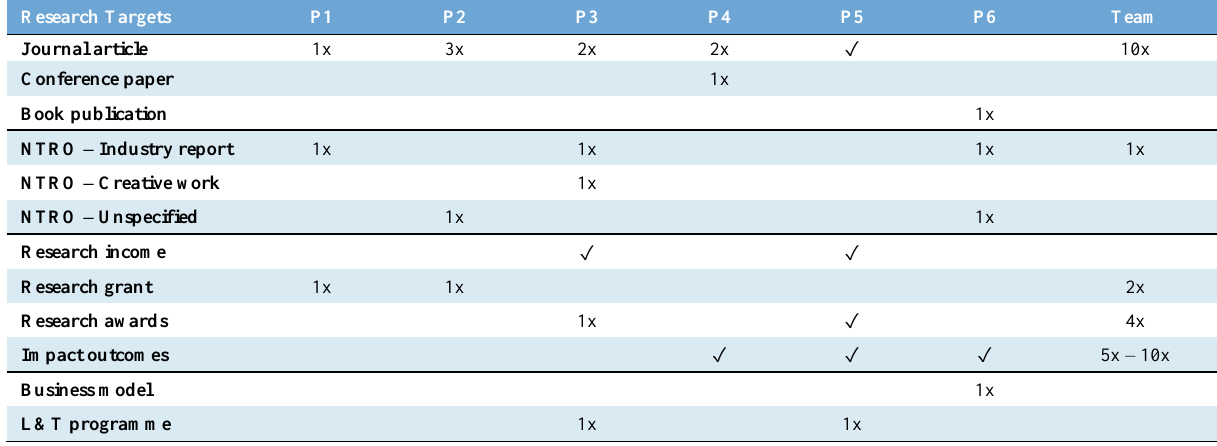
Table 1. Individual (P1 to P6) and team-based research